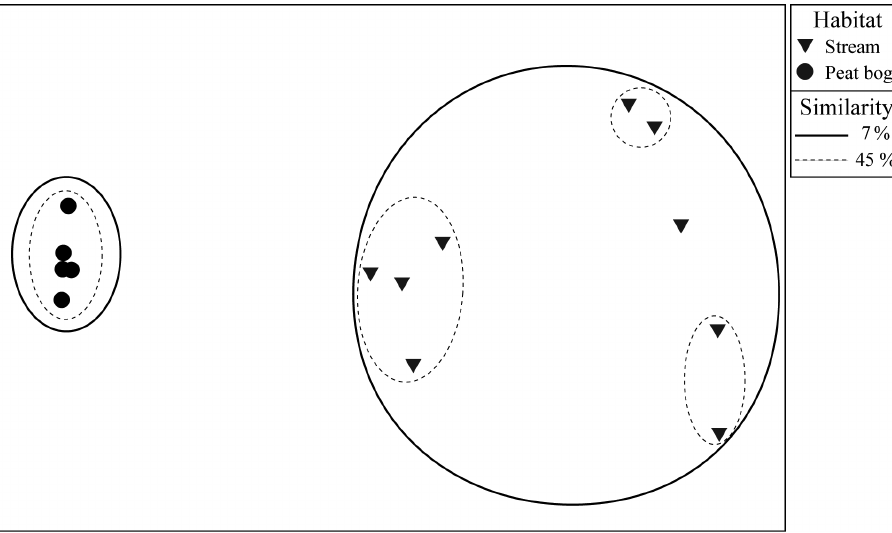
Figure 3. Ordination of non-metric multidimensional scaling of mayfly assemblages based on Bray- Curtis similarity coefficient (group average linking) and their square root transformed abundances, with superimposed data of hierarchical cluster